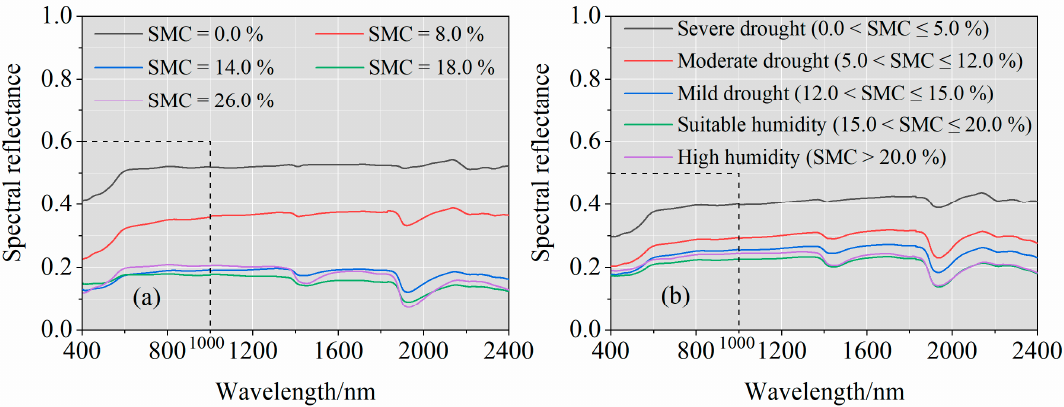
Figure 6. Soil spectrum curves under different humidity conditions. ( a ) spectral curves selected from the indoor soil moisture control experimental spectral data; ( b ) spectral curves obtained after averaging 171 soil samples according to the soil moisture grading standard.